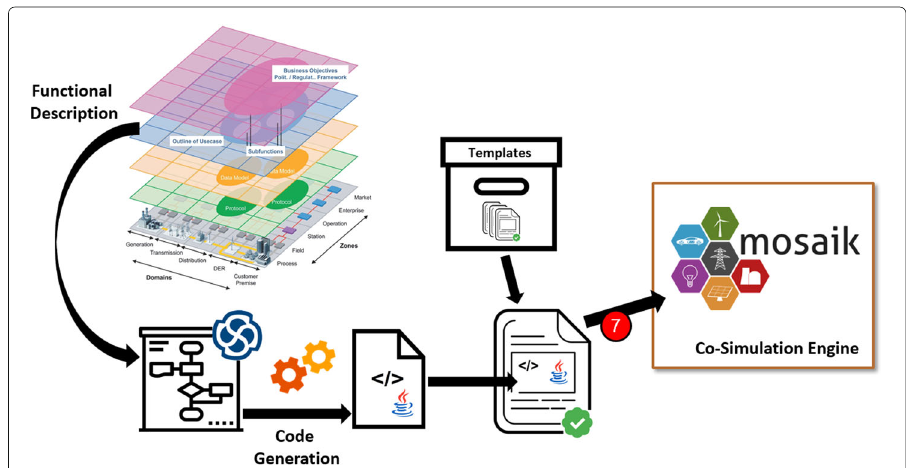
Fig. 3 Simulation approach based on SGAM